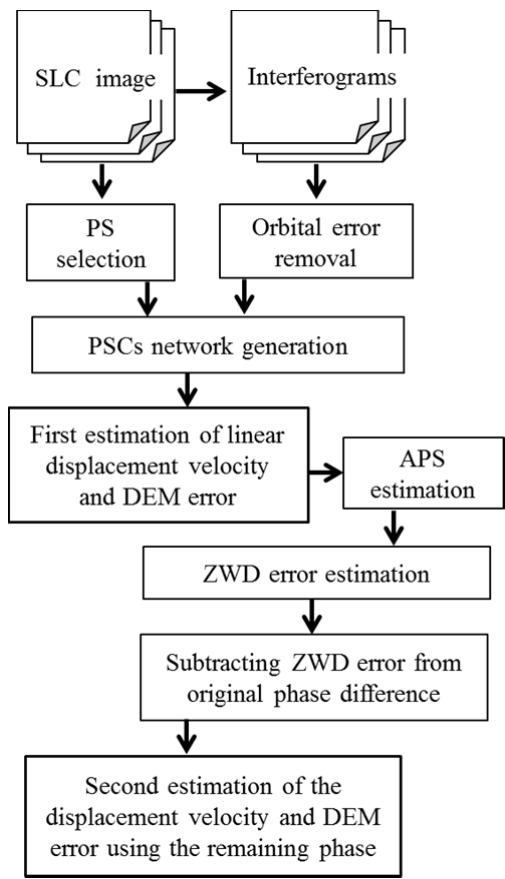
Figure 3. Removal of phase error due to ZWD in the PSInSAR technique.